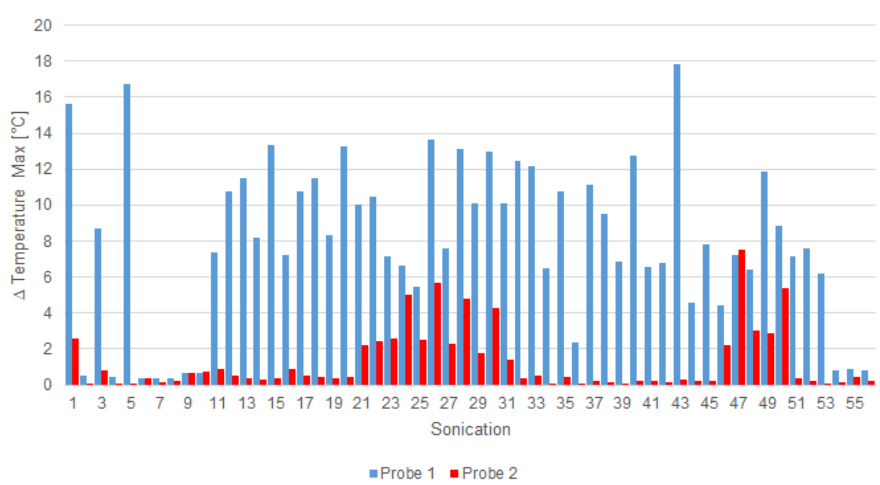
Figure 8. SNR values calculated for the phantom, skin, and gel ROIs. The phantom signal had the highest SNR values, while the gel area and the skin-interface area had the lowest SNR values.